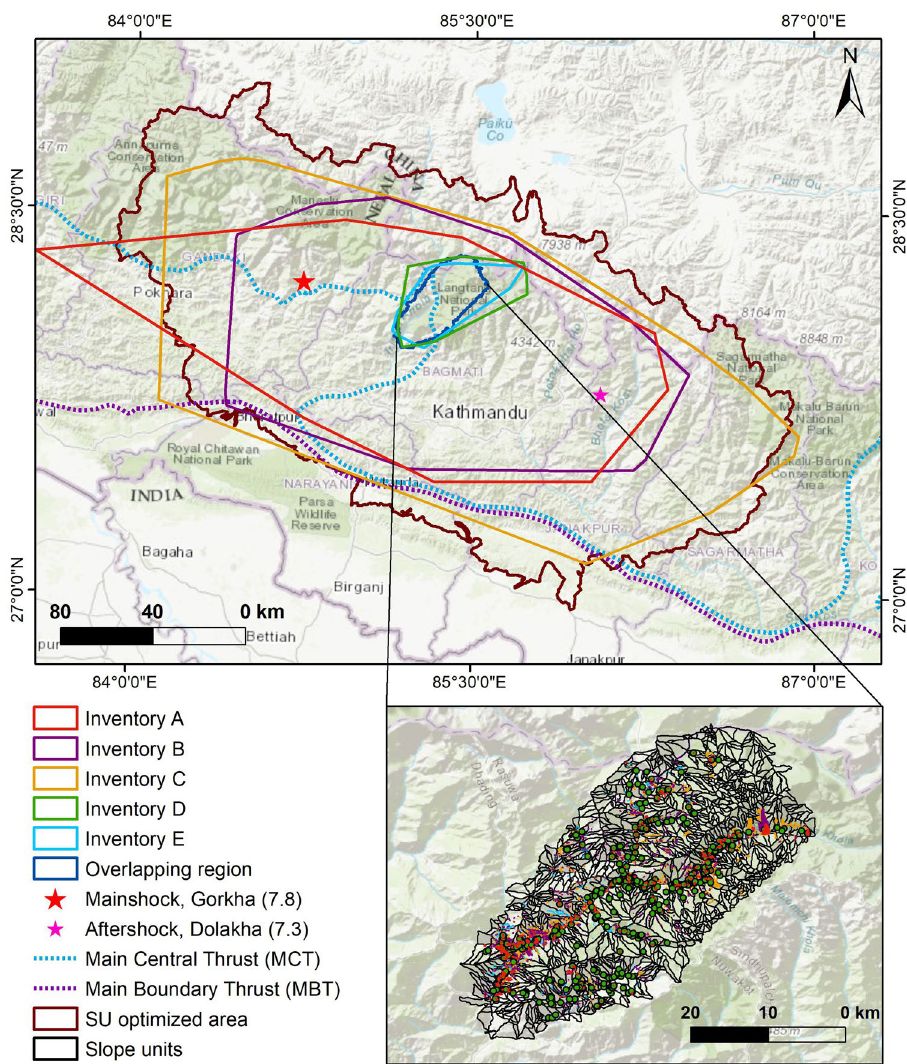
Figure 1. Map of the study area showing the extent of inventories considered in this work, overlapping region, earthquake epicenter and major thrust systems; thrust system modified after Stocklin 36 . The base layer is “World Topograhic Map” available as ArcGIS Online basemap (https:// www. arcgis. com/). The map was created using ArcGIS version 10.8.1 (https:// www. esri. com/).